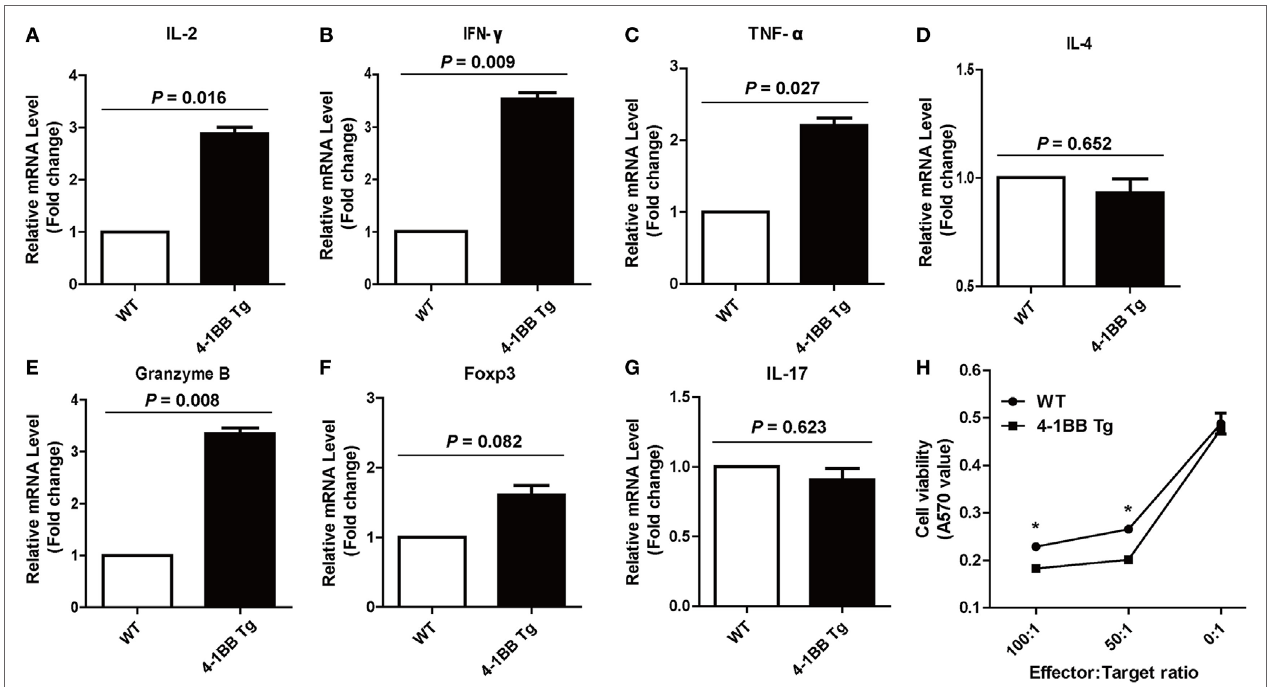
FigUre 5 | 4-1BB overexpression enhances specific Th1 cytokines production and cytotoxic T lymphocyte (CTL) function during the recall response. Levels of IL-2 (a) , IFN- γ (B) , TNF- α (c) , IL-4 (D) , granzyme B (e) , Foxp3 (F) , and IL-17 (g) mRNA expression in peripheral blood lymphocytes were determined by quantitative real-time PCR following porcine reproductive and respiratory syndrome virus (PRRSV) restimulation in vitro . CTL assay (h) was performed with PRRSV-infected porcine alveolar macrophages as target cells and peripheral blood lymphocytes from PRRSV-vaccinated pigs as effector cells. 4-1BB Tg, 4-1BB transgenic pigs; WT, wild-type pigs used as a control. The results shown are representative of three independent experiments. Data are presented as mean values ± SEM. P < 0.05 was considered statistically